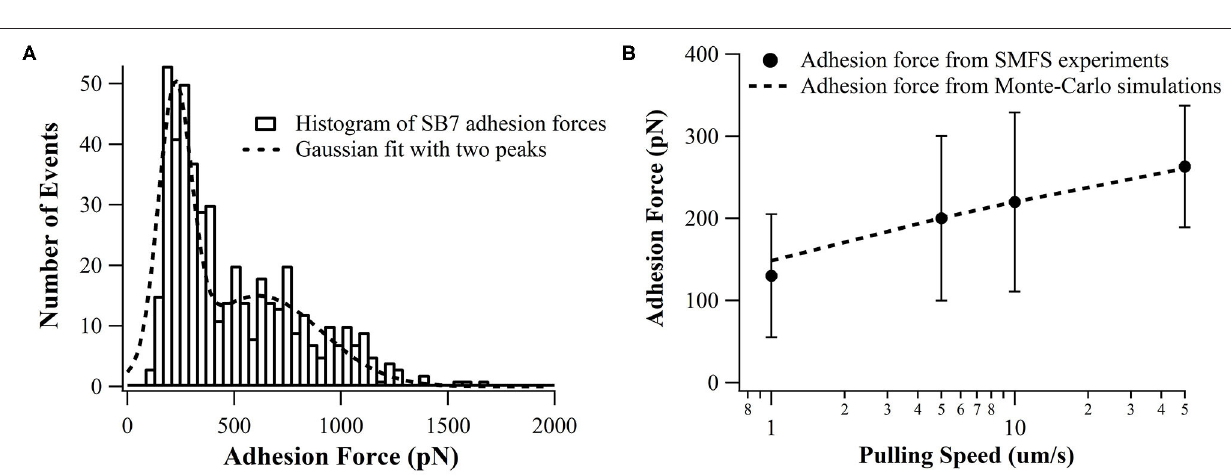
of the 35 kDa PEG linker. In this work, most of the 35 kDa PEG linker has a contour length of ∼ 300 nm indicated by